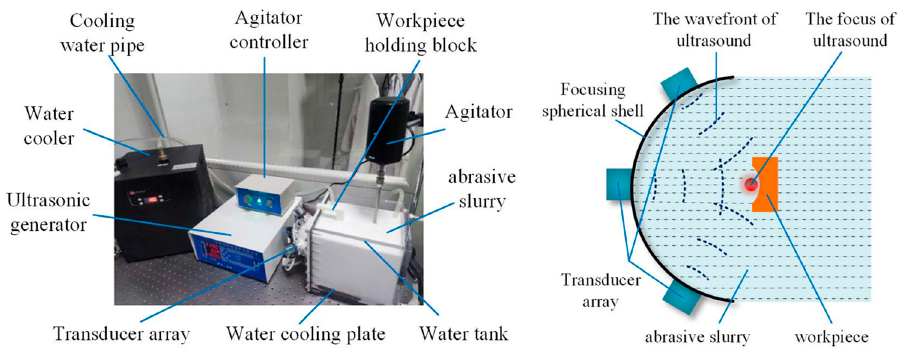
Figure 1. Experimental platform and machining principle of spherical-array-focused ultrasonic abrasive machining.